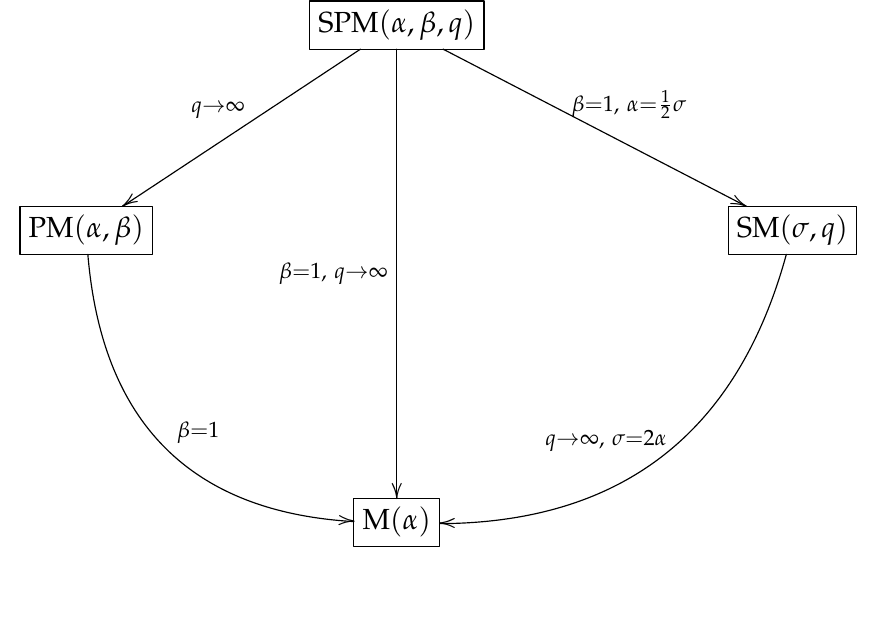
Figure 3. Relationship among distributions of the SPM